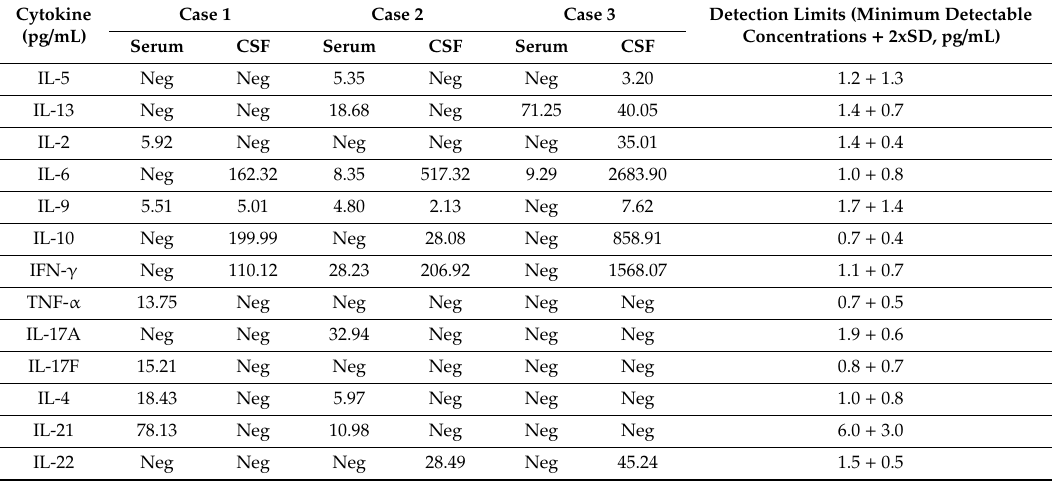
Table 3. Anti-Viral Cytokine Levels in Patients with Toscana Virus Neuroinvasive Infection. Cytokine (pg /